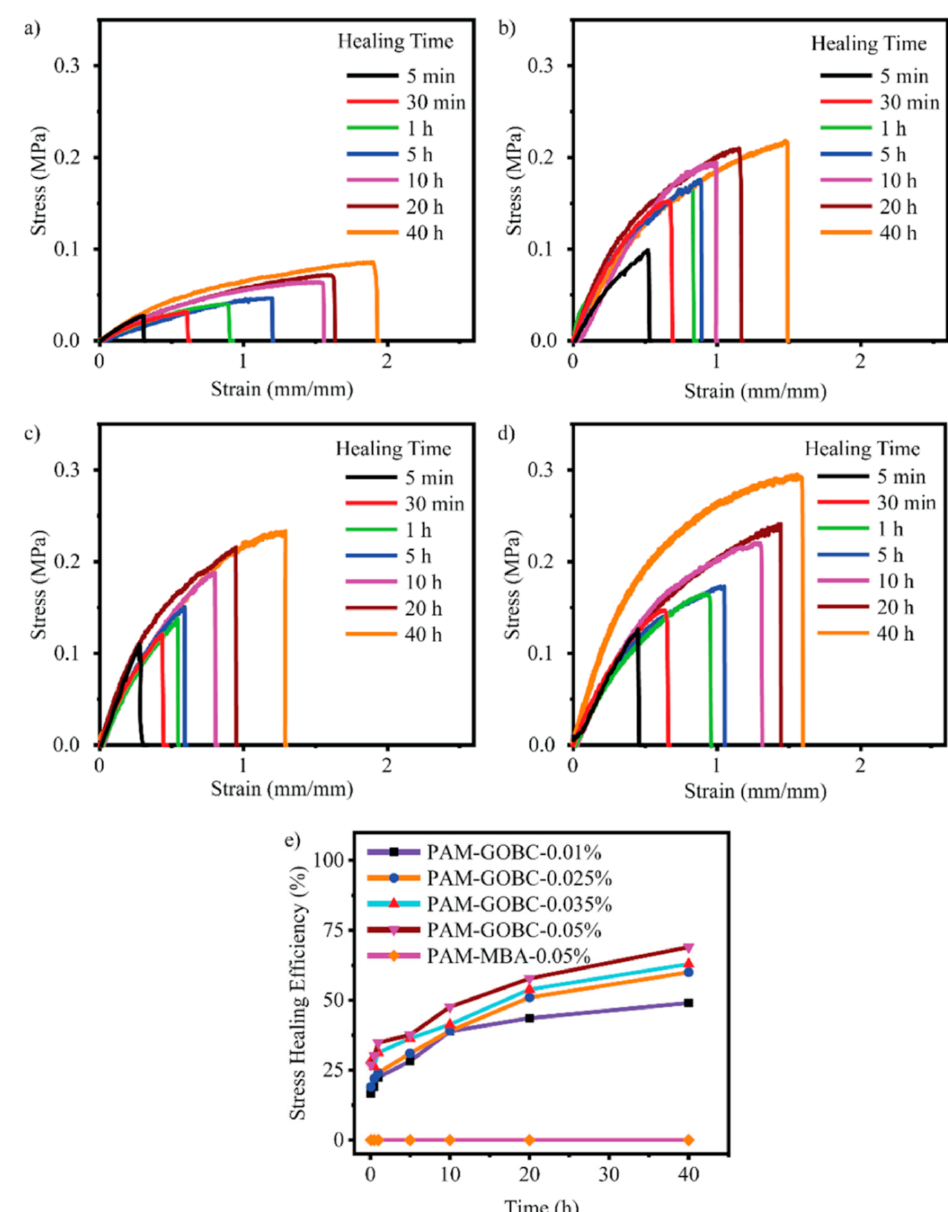
Figure 2. Illustration of the stress-strain curve of healed PAM hydrogels with a ( a ) 0.01%, ( b ) 0.025%, ( c ) 0.035%, ( d ) 0.05% GOBC, and ( e ) demonstrated the stress healing kinetics with different time. This picture adopted from Rumon et al. [16]. “This study is under Creative Commons Attribution 4.0 International License, which permits use, sharing, adaptation, distribution, and reproduction in any medium or format, as long as you give appropriate credit to the original author(s) and the source as well as provide a link to the Creative Commons license (http://creativecommons.org/licenses/by/4. 0/, accessed on 19 October